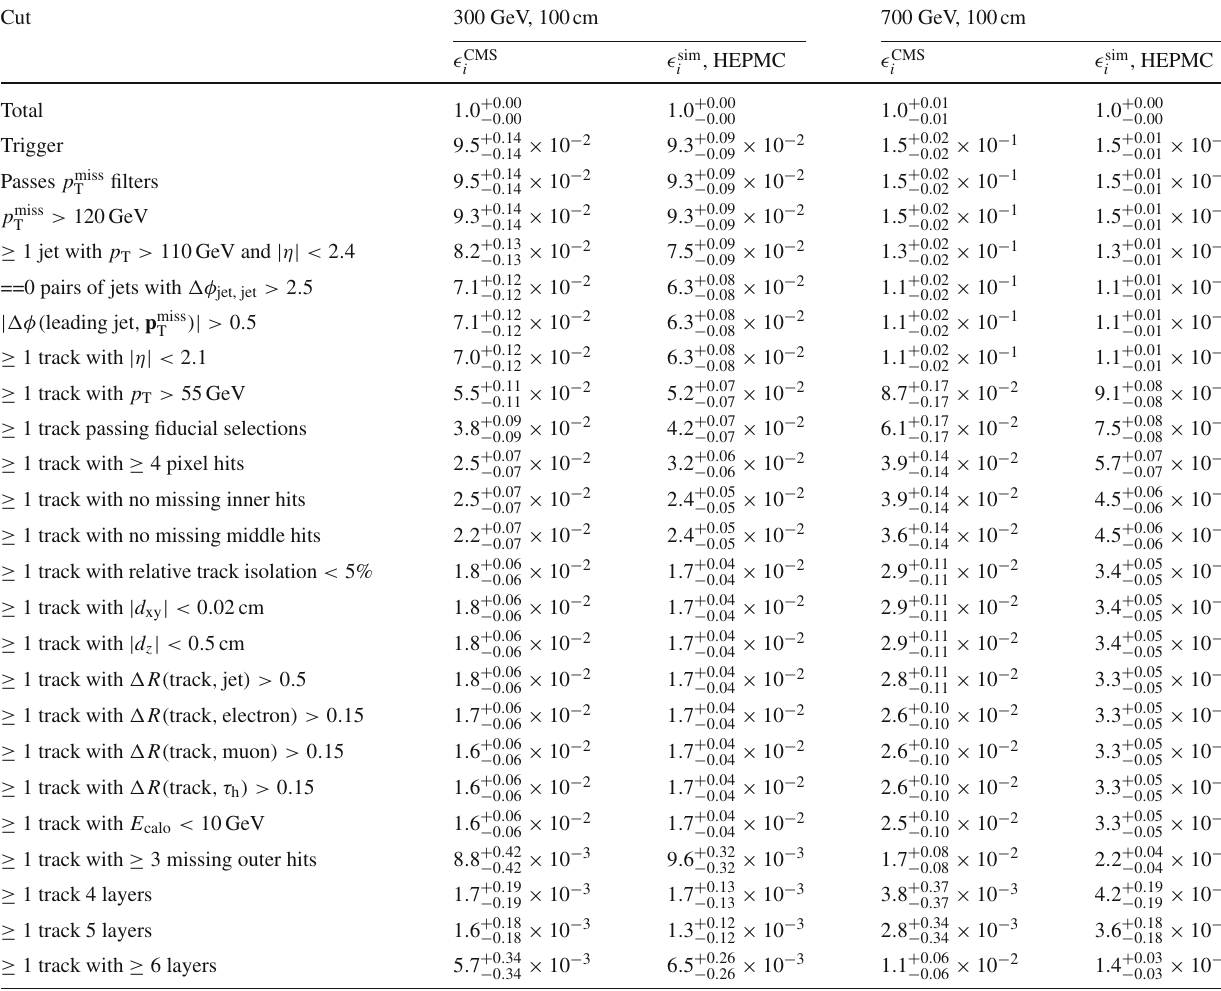
Table 9 Cutflow comparison for signal region 2018A and decay length 100cm, for 300 GeV and 700 GeV winos